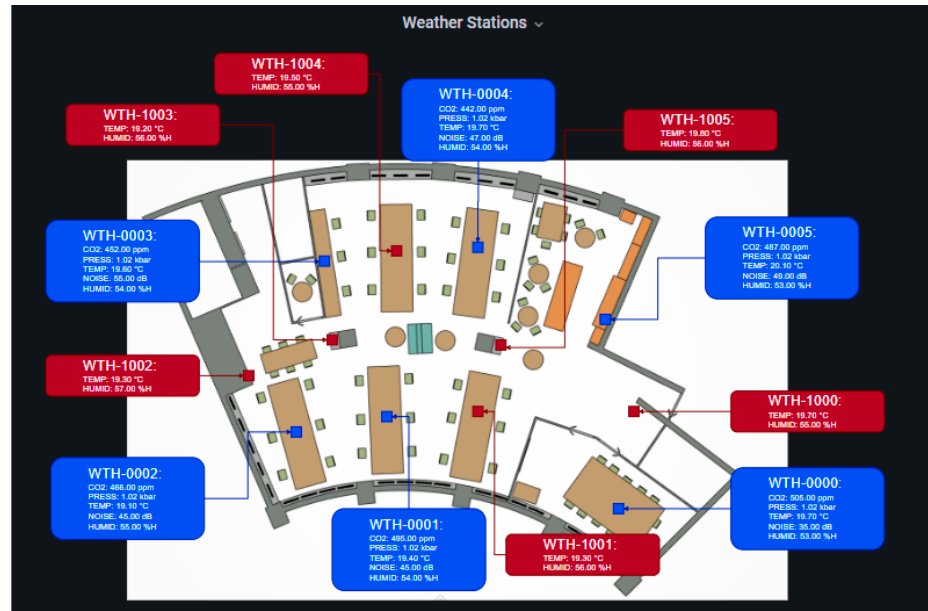
Figure 9. Grafana dashboard of office worksite and weather station sensors.